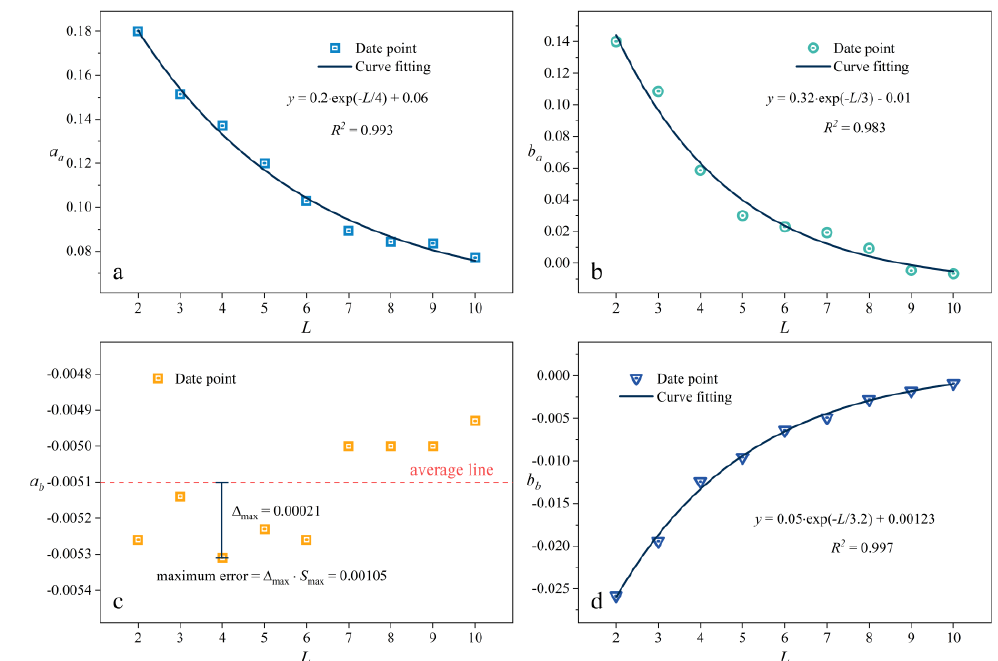
Figure 9. Analysis of the linear relationship. ( a ): The relationship of a a about L ; ( b ): The relation- ship of b a about L ; ( c ): The relationship of a b about L ; ( d ): The relationship of b b about L .